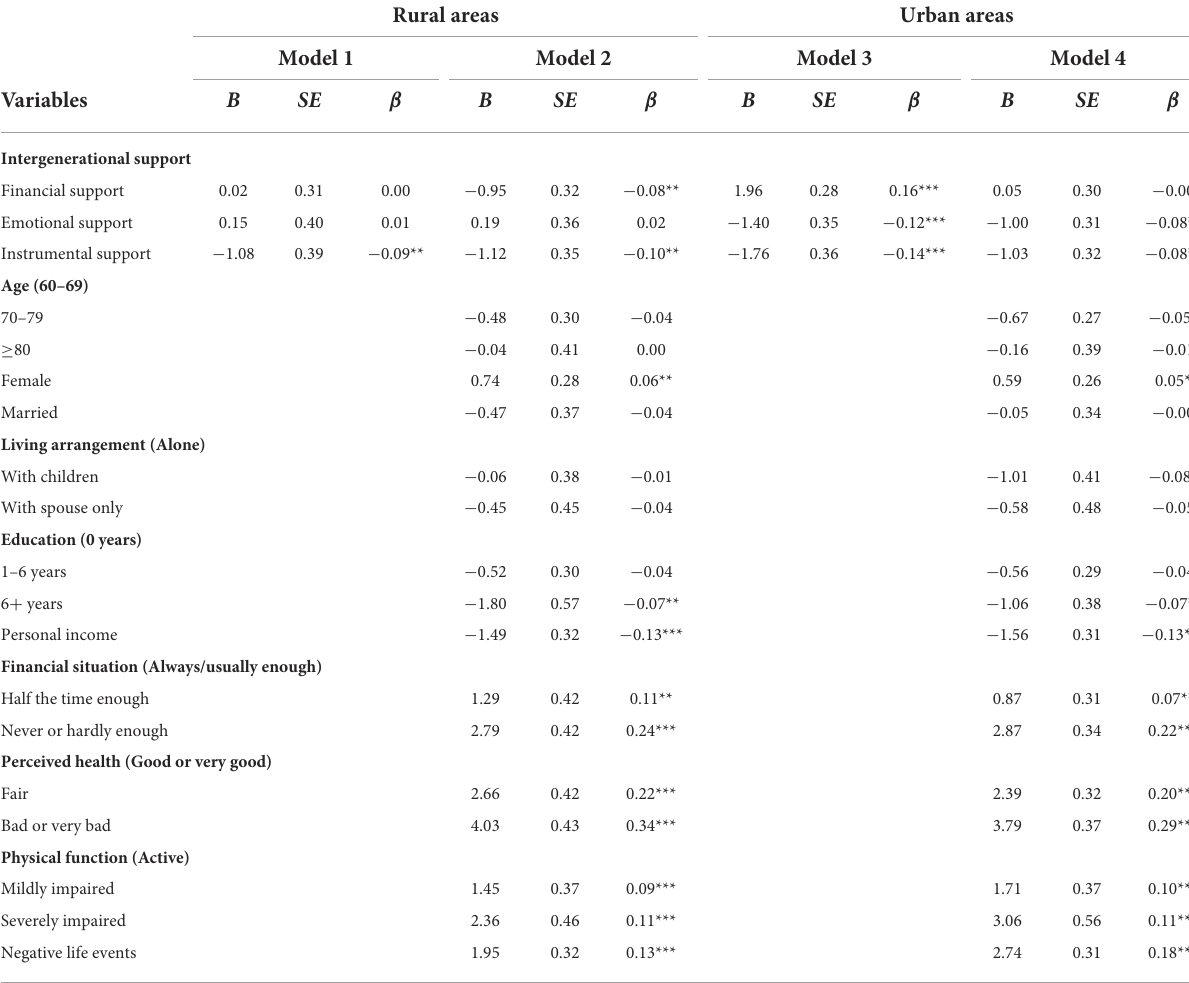
TABLE 4 Multiple liner regression models of intergenerational support on depressive symptoms in the two areas. Rural areas Urban areas Model 1 Model 2 Model 3 Model